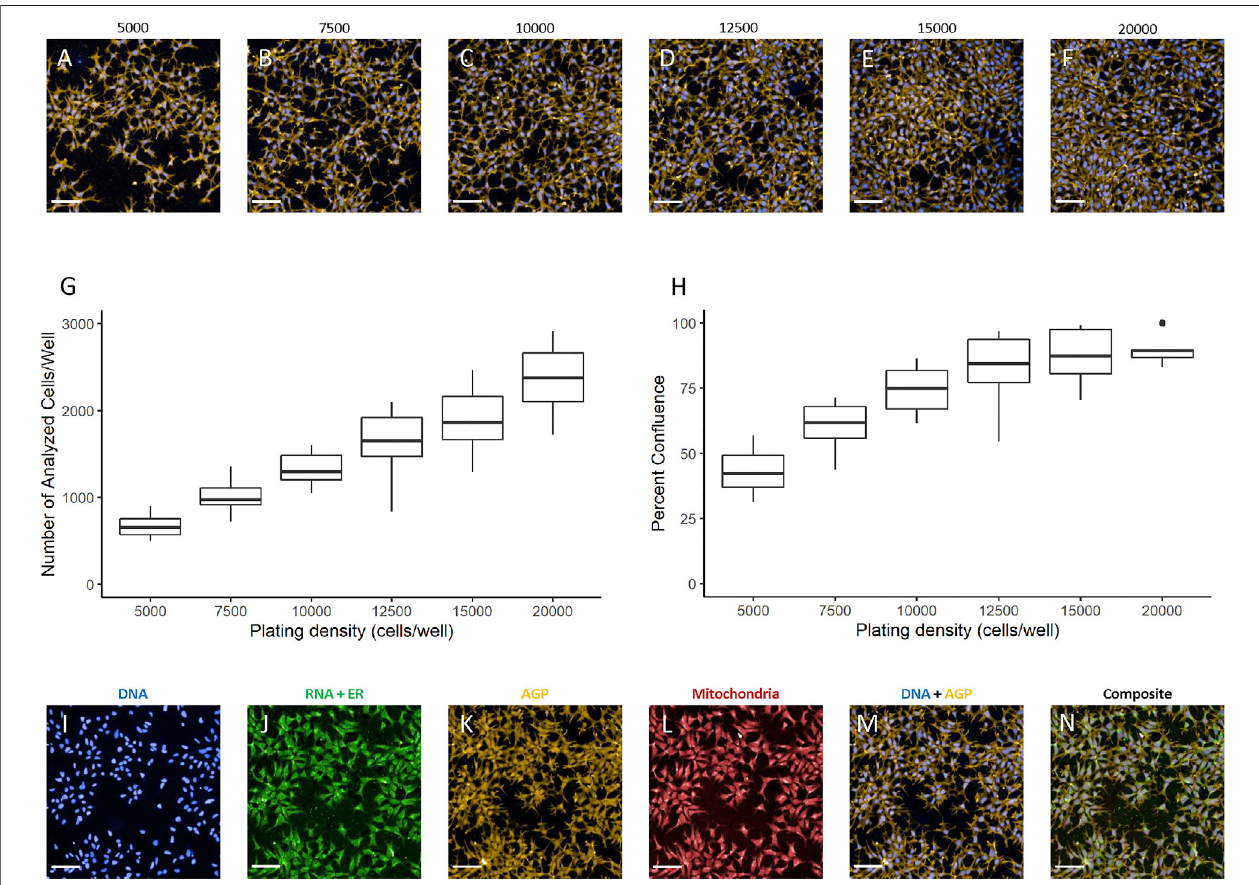
FIGURE2| Platingdensitydetermination.Imageswerecapturedwitha20XwaterimmersionobjectiveandHarmony ® softwarewasusedforfurtherprocessing.A representativeimageoftheDNA+AGPchannelsat5,000 (A) ,7,500 (B) ,10,000 (C) ,12,500 (D) ,15,000 (E) ,and20,000 (F) cells/wellisdisplayed.Well-leveldatawere exported to assess the number of analyzed cells/well (G) and percent con fl uence (H) in R statistical software. Graphs represent three biological replicates (i.e., independent cultures) which includes 16 technical replicates/density per biological replicate. Representative images at 6,000 cells/well visualized using the DNA (I) , RNA + ER (J) , AGP (K) , mitochondrial (L) , DNA + AGP (M) , and all channels combined (N) are provided. Scale bar = 100 µm.